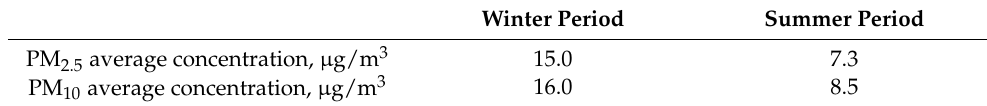
Table 6. Average particulate matter concentration during the summer and winter